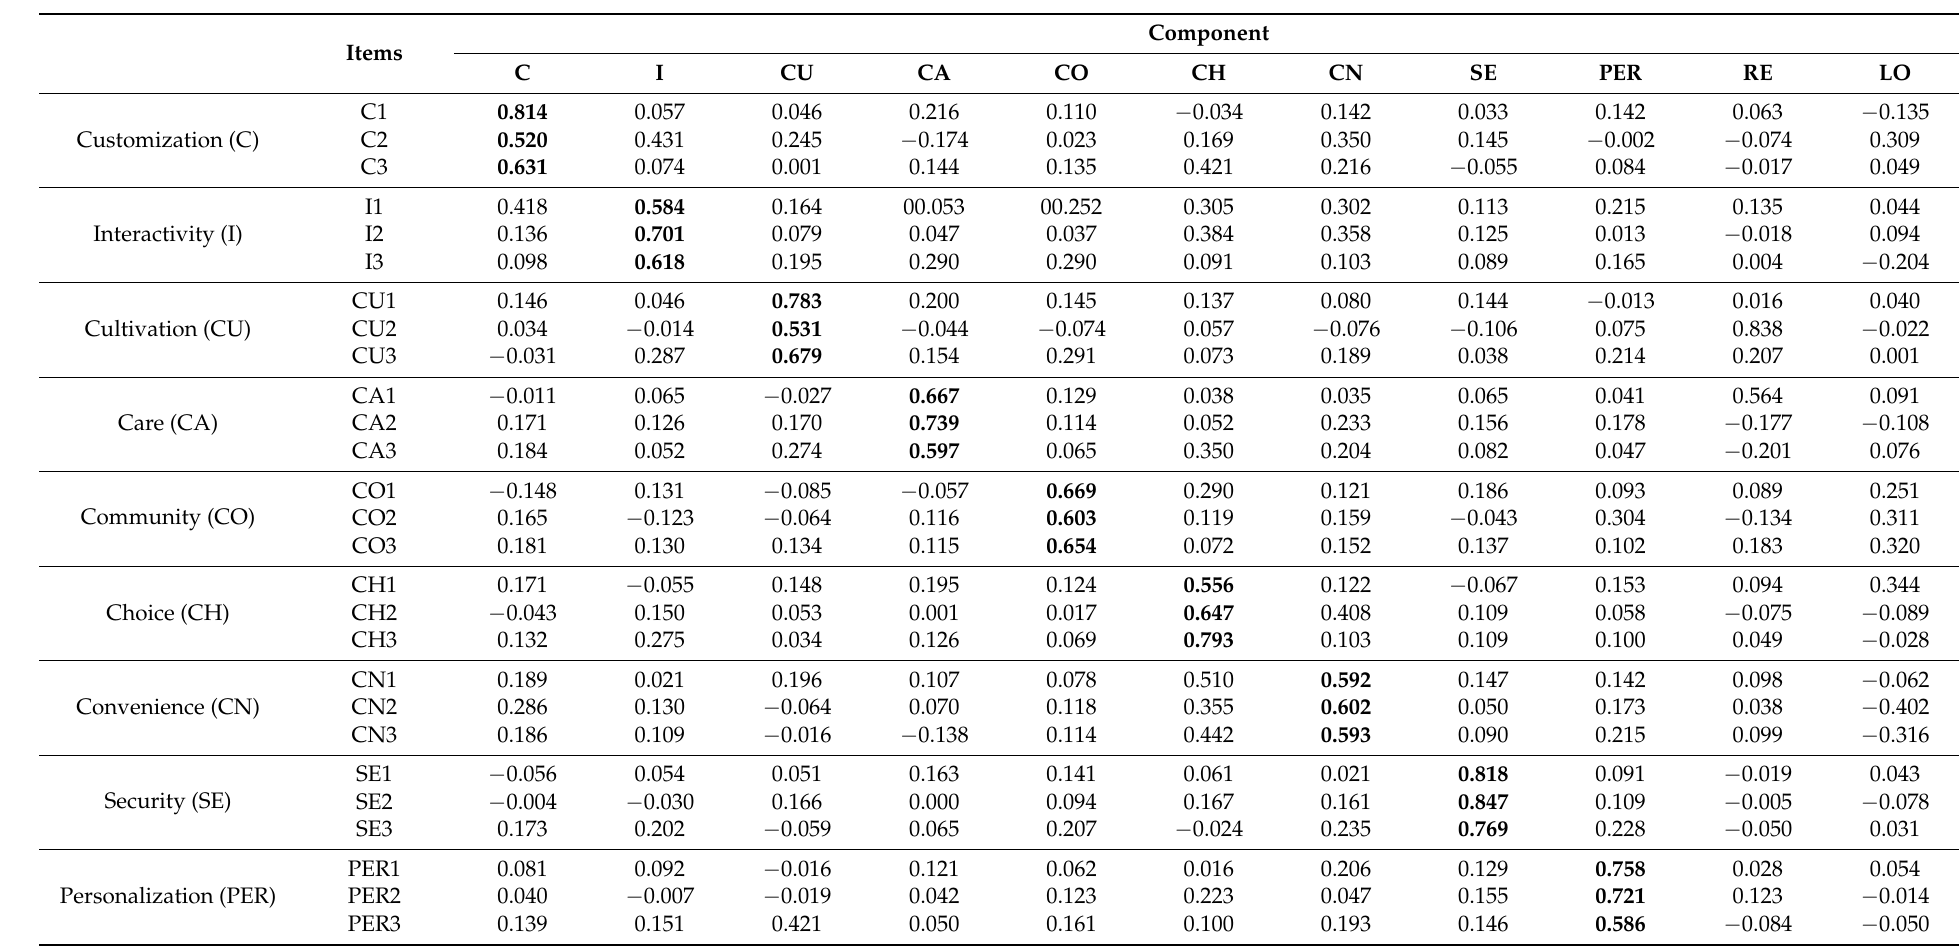
Table A1. Rotated component matrix a